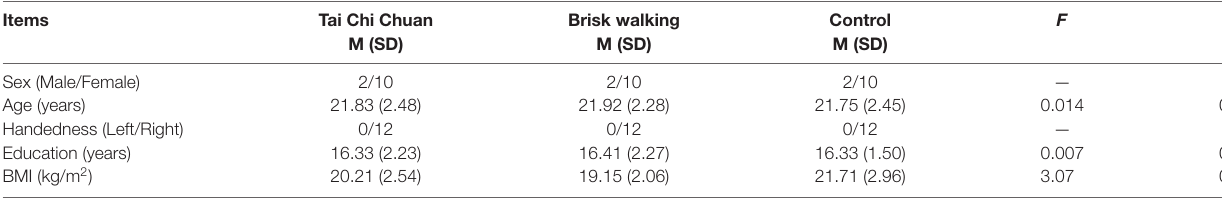
TABLE 1 | Demographic characteristics.